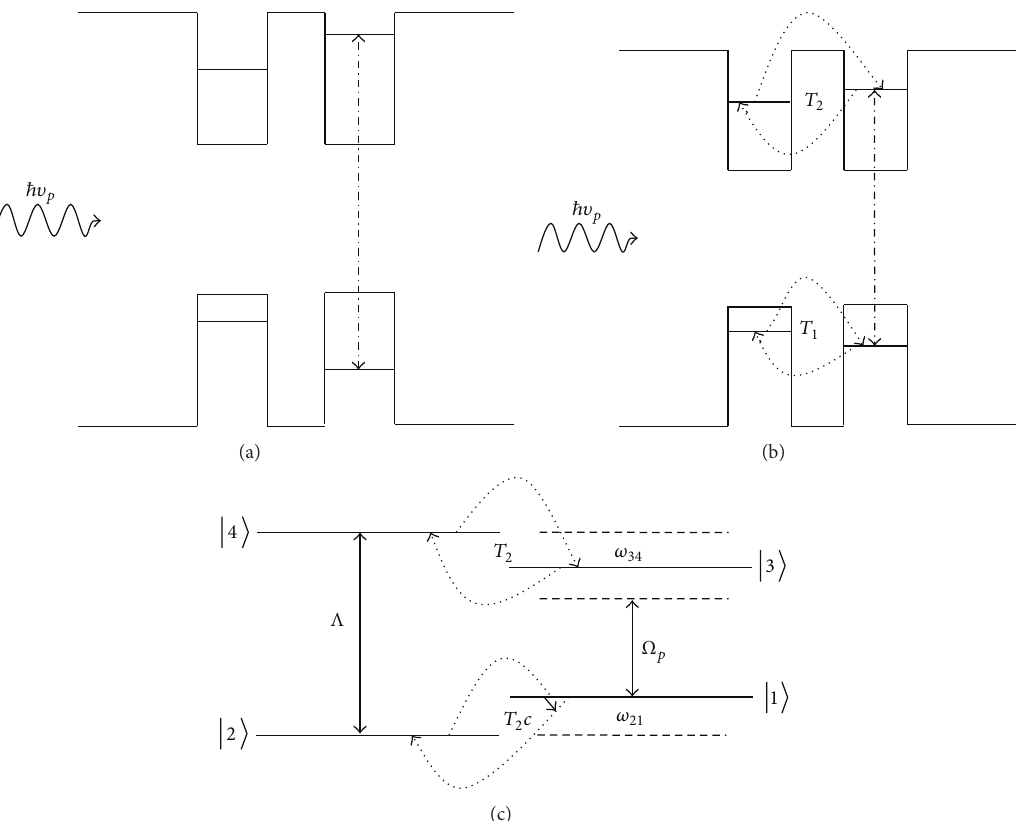
Figure 1: Schematic band structure and level configuration of a double QD system. (a) Without a gate voltage, electron tunneling is weak. (b) With applied gate voltage, conduction and valence band levels get into resonance, increasing their coupling. (c) Levels taken into account by Hamiltonian model and the basis of states used to describe